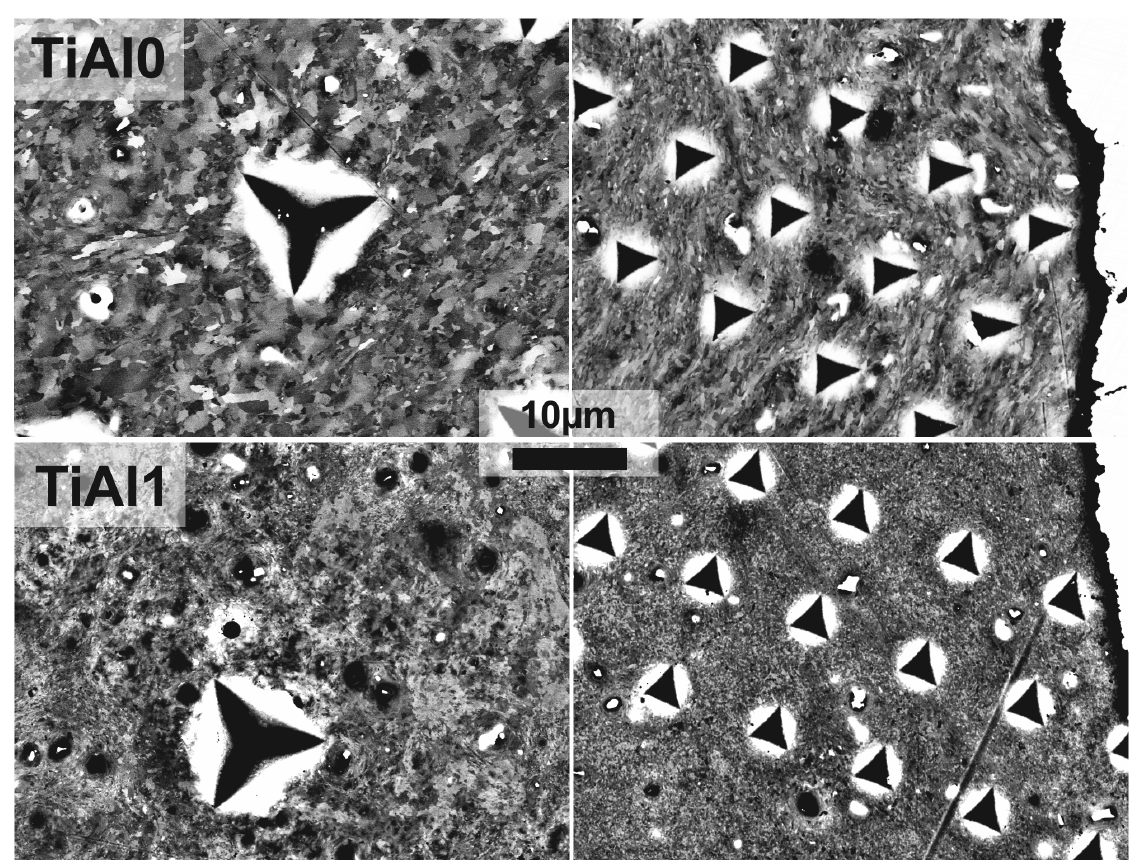
Figure 5. Back scattered electron images of Al microstructure in TiAl0 (upper row) and TiAl1 (bottom row); left side: far from the boundary; right side: close to the phase